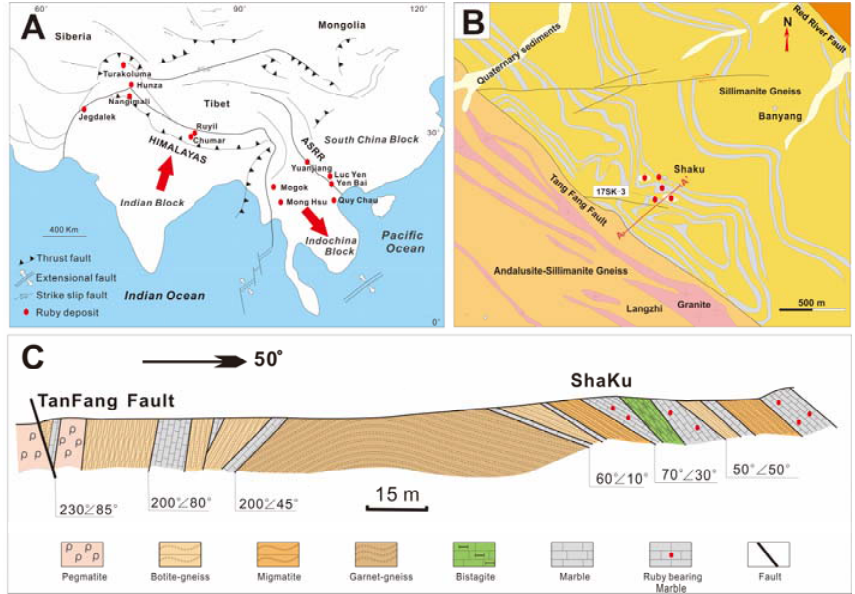
Figure 1. ( A ) Outcrop of marble-hosted ruby deposits in Central and Southeast Asia (modified after [1]). ( B ) Geological map of the Yuanjiang marble-hosted ruby deposit (modified after [5]). ( C ) The cross-section profile map of Shaku anticline (Its location corresponds to A–A ′ in Figure 1B).